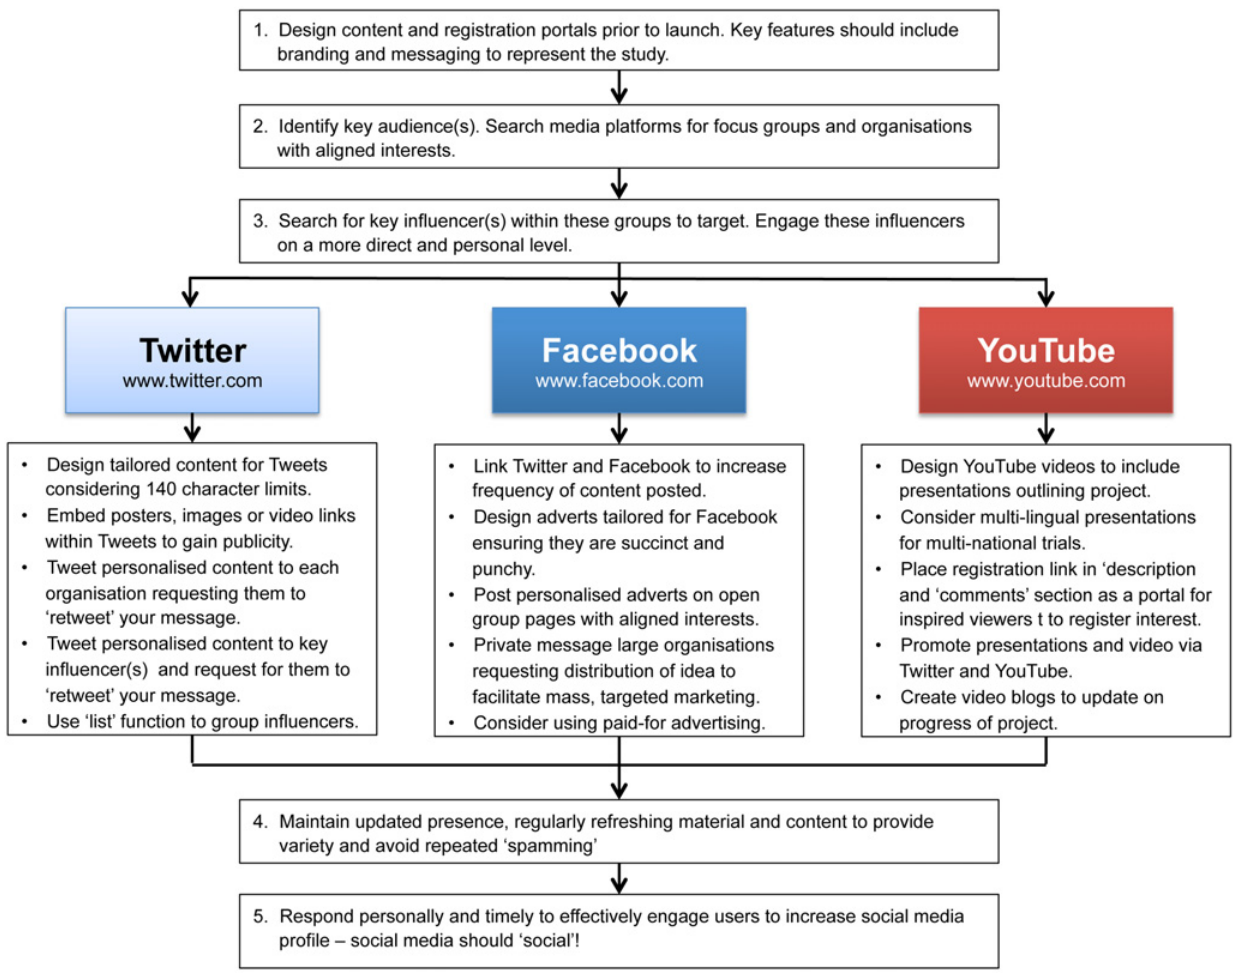
Fig 2. Suggested practical model recruitment strategies for utilising social